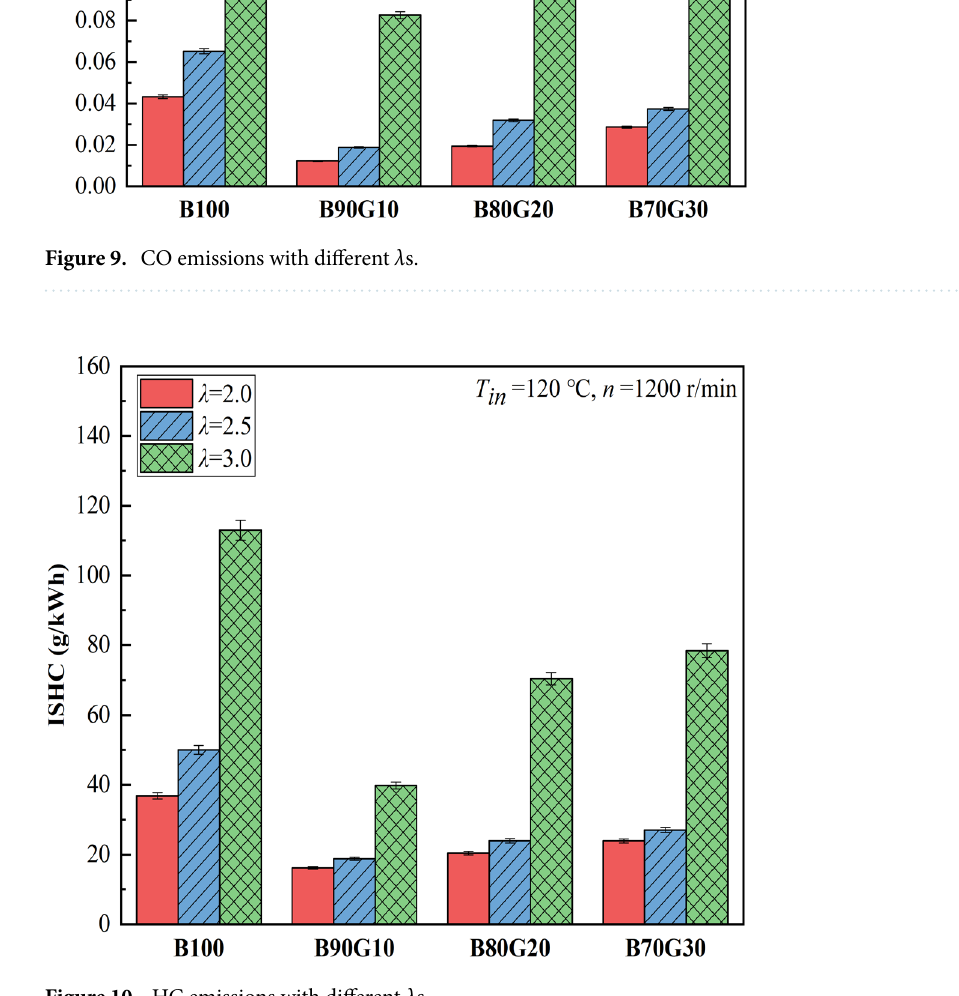
Figure 10. HC emissions with different λ